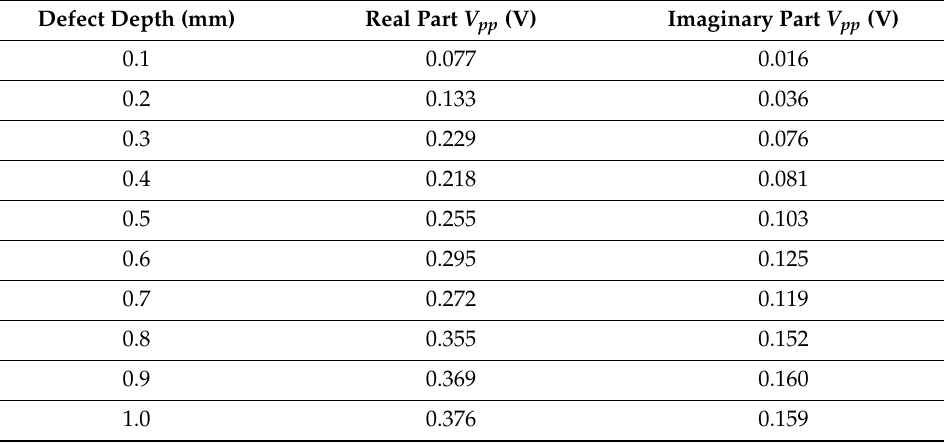
Table 1. Real and imaginary part output from probe A of 5-mm length but di ff erent depth defects.